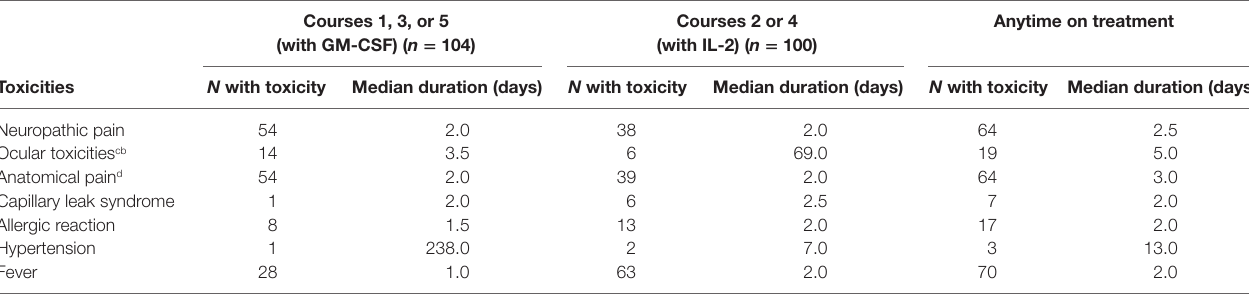
The average cytokine levels of patients with AR were indis- tinguishable from the overall population, with no significant differences in the levels of the cytokines between the “non-AR” versus the “any AR” population of patients, except for course 1